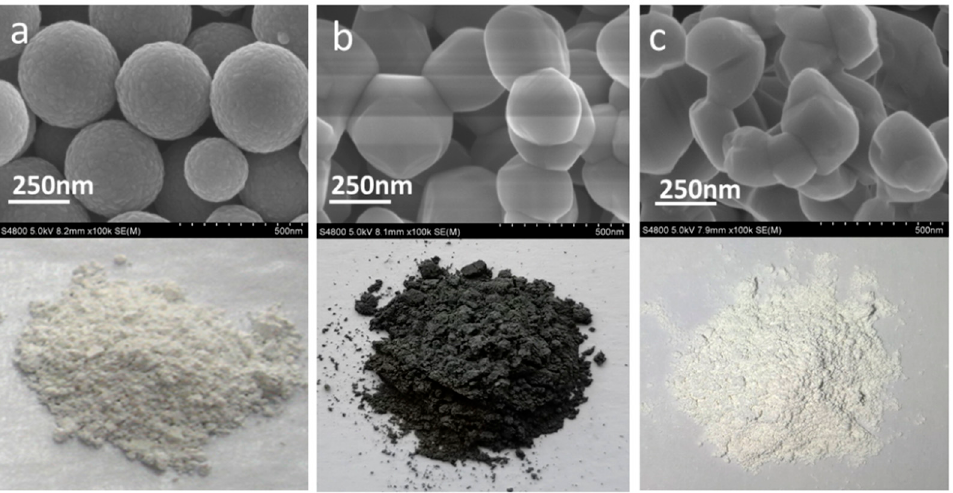
Figure 1. Morphology of spherical anatase TiO 2 ( a ), TiO 2 -gray rutile (TiO 2 -GR) ( b ), and TiO 2 -white rutile (TiO 2 -WR) ( c rutile (TiO 2 -WR) ( c ).